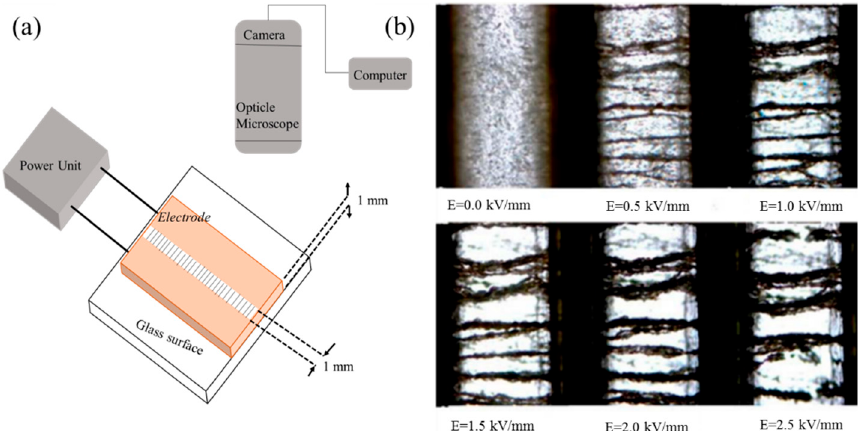
Figure 10. ( a ) Schematic illustration of polarizability measuring device; ( b ) optical microscope (OM) images showing the polarization of nanocube-TiO 2 /poly(3-octhlthiophene)-based ER fluid, reprinted with permission from [104]. Copyright John Wiley and Sons, 2016.